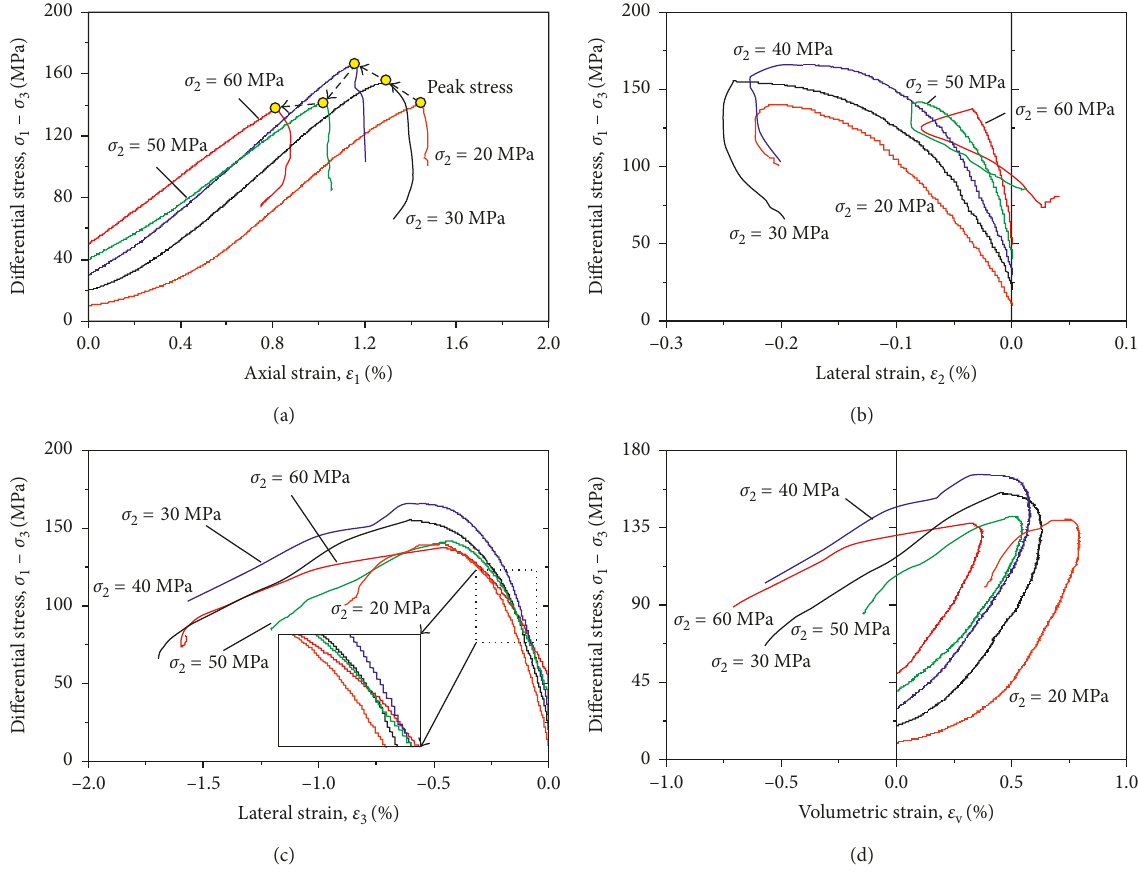
Figure 6: Differential stress ( σ (a) differential stress ( σ 1 ( ε 2 ); (d) differential stress ( σ 1